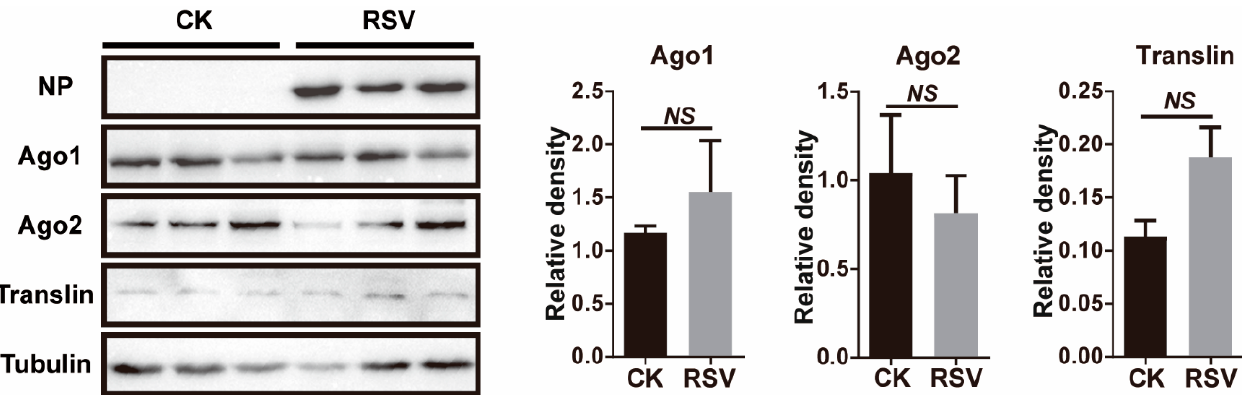
Figure 2. Western blot assay showing the protein levels of NP, Ago1, Ago2, and Translin in the planthoppers at 6 d after injection of RSV crude preparations. The crude preparations from nonviruliferous planthoppers were injected into the control group (CK). Three biological replicates were shown for each group. The monoclonal antibodies for NP, Ago1 and Ago2, and polyclonal antibody for Translin were used. The protein level of planthopper tubulin was revealed using the monoclonal anti ‐β‐ tubulin antibody as an internal reference. The relative grayscales of Ago1, Ago2, and Translin to that of tubulin were quantified and compared between the RSV ‐ infected and CK groups. The values represent the means ± SEs. NS, no significant difference.